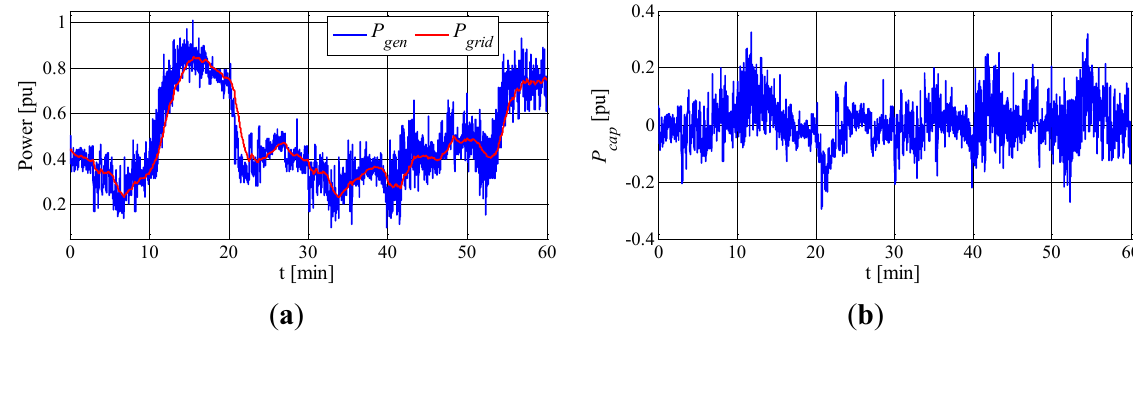
Figure 9. Simulation results under normal conditions ( a ) D-PMSG output power and the power transferred to the grid; ( b ) Power transferred to the super-capacitor